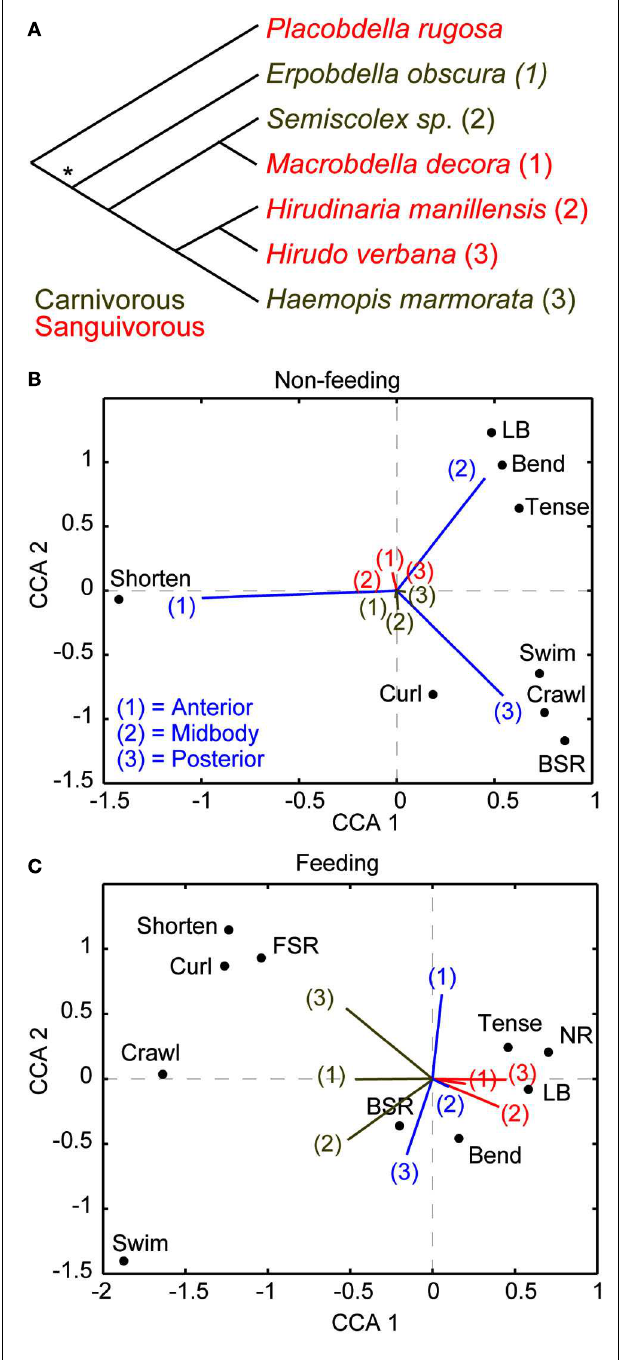
FIGURE 1 | Diet and not phylogeny determine leech behavioral choice. (A) The phylogenic relationship of leeches used for this study (Gaudry et al., 2010) is based on a comparison of morphological and molecular features (Borda and Siddall, 2004). An asterisk implies an ancestral state of unknown feeding preference.The most parsimonious explanation of these relationships is that the sanguivorous feeding strategy evolved three different times among these species from a carnivorous ancestor.The numbers following each species is used to reference that species in (B,C) . (B) Canonical Correspondence Analysis (CCA) biplot showing the